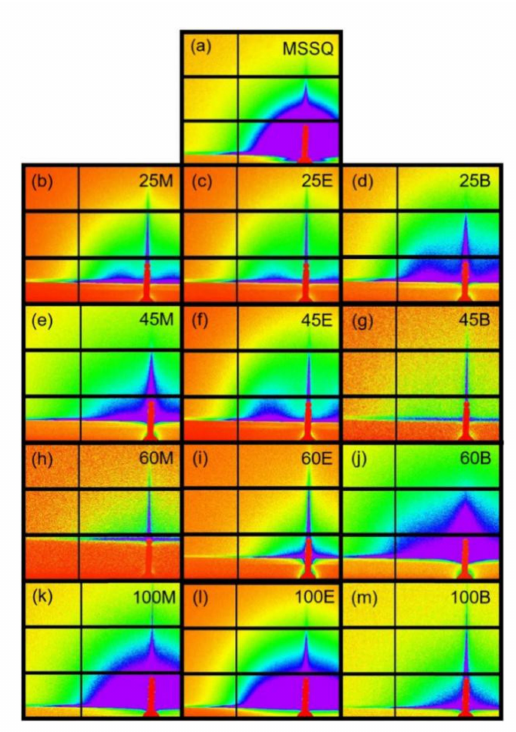
Figure 10. Grazing-incidence small-angle X-ray scattering patterns of porous organosilicate glass films: ( a ) methylsilsesquioxane (MSSQ); ( b ) 25M; ( c ) 25E; ( d ) 25B; ( e ) 45M; ( f ) 45E; ( g ) 45B; ( h ) 60M; ( i ) 60E; ( j ) 60B; ( k ) 100M; ( l ) 100E; ( m ) 100B, where M is the methylene bridge (BTESM), E—ethylene bridge (BTMSE), B—1,4-phenylene bridge